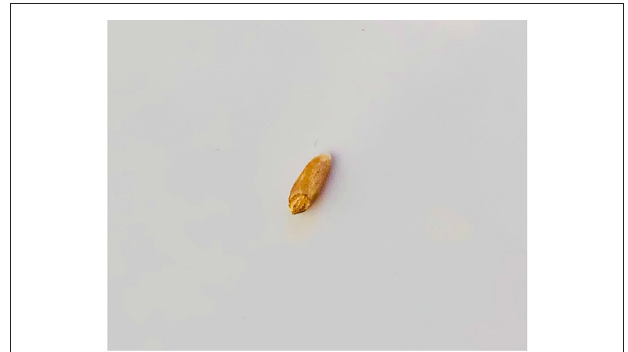
FIGURE 2 | Errant wheat grain.